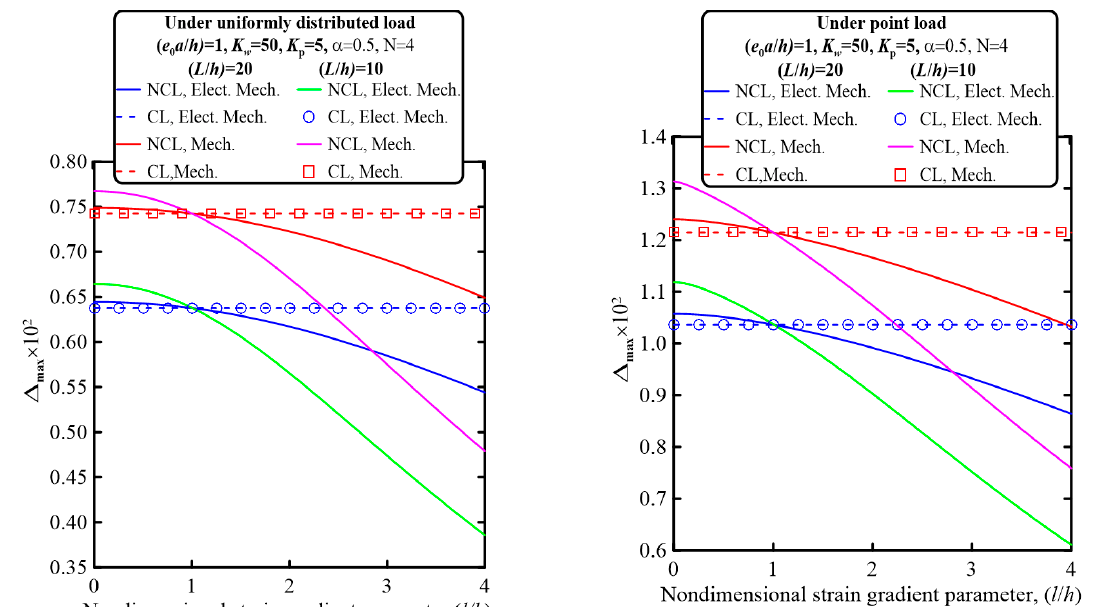
Figure 8. Variation in the maximum normalized transverse deflection Δ max with the nondimensional strain gradient parameter ( l / h ) for nonclassical and classical electromechanical and mechanical behaviors under uniformly distributed and point loads at different values of the nonclassical and elastic foundation parameters at α = 0.5 and beam aspect ratio L / h = 10, 20, L = 100 nm, N = 4, e 311 = − 4.1